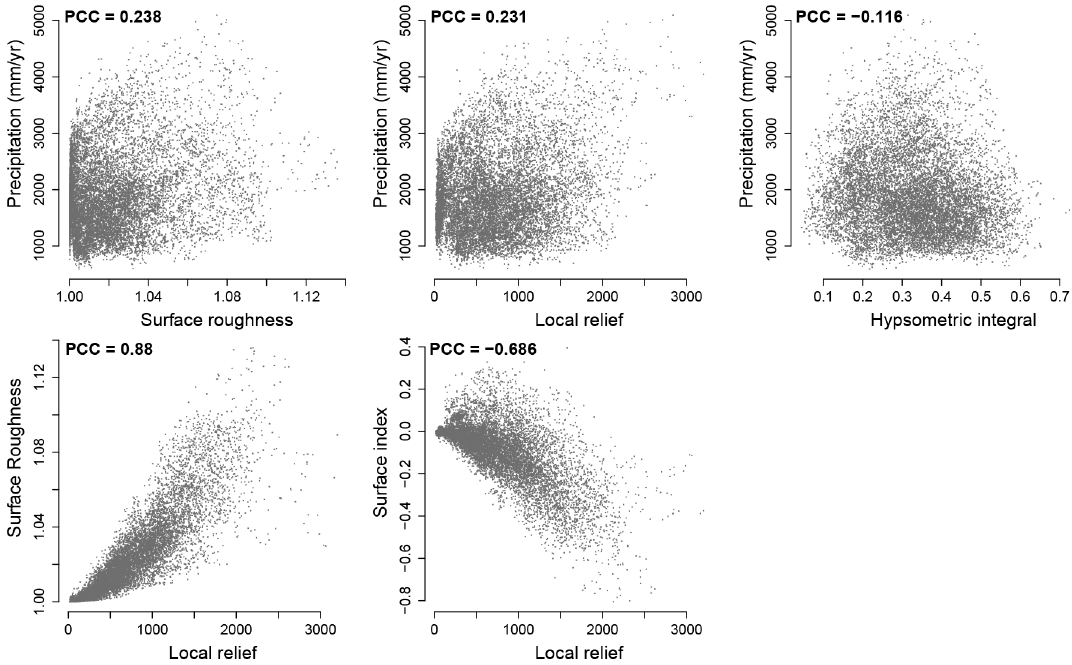
Figure 9. Comparison between precipitation (derived from TRMM data) and morphometric indices within the Sierra Madre de Chiapas. Points represents pixel values extracted from the precipitation (Fig. 5b) and morphometric maps (Figs. 7 and 8). The linear correlation between the variables was estimated using the Pearson correlation coefficient (PCC).